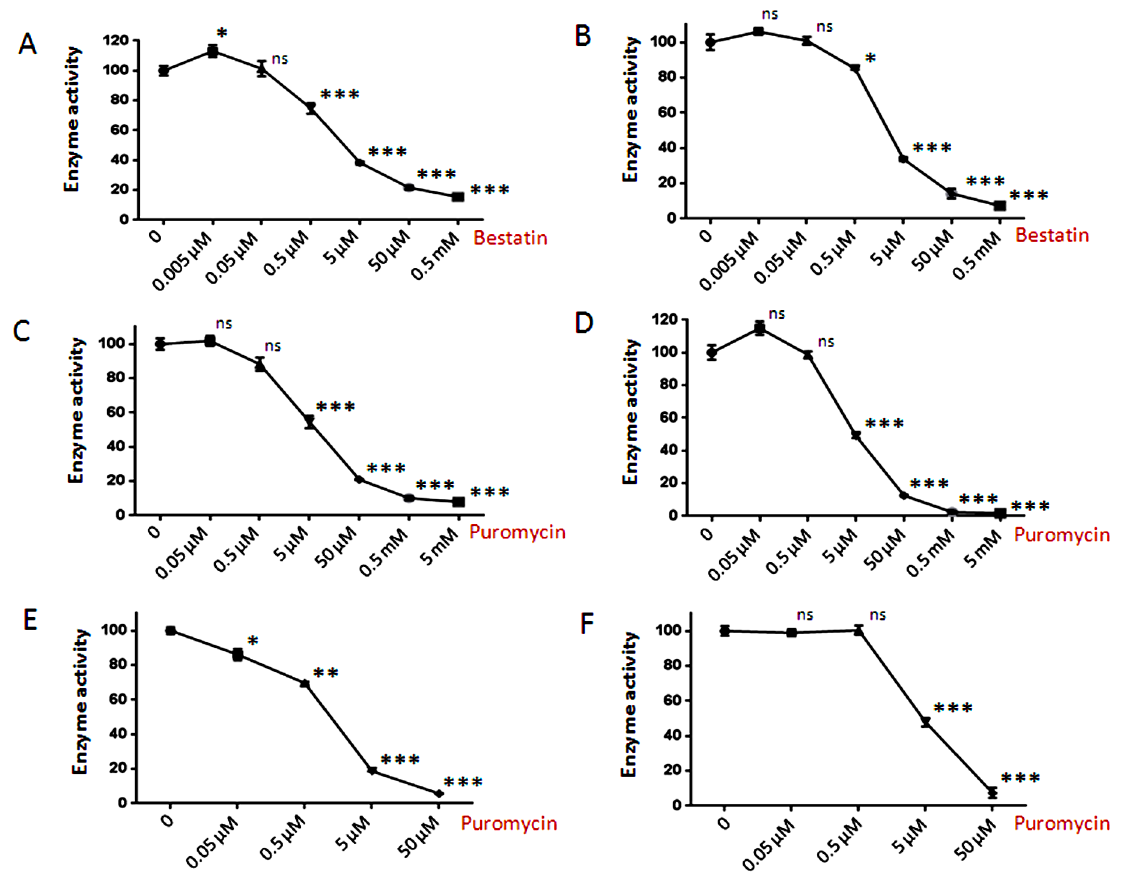
Figure 7. Effect of aminopeptidase inhibitors on Ala-AMC and Leu-AMC cleavage. HEK 293T cell extract (panels A–D) or recombinant PSAP (panels E–F) were treated with increasing concentrations of bestatin or puromycin for 30 minutes followed by the addition of substrate and incubation for 1 hour. Enzyme activity was determined by fluorescence measurement of AMC and expressed as percentage enzyme activity relative to the control without inhibitor. (A) Bestatin inhibition of HEK293T cell extract assayed with Ala-AMC. (B) Bestatin inhibition of HEK293T cell extract assayed with Leu-AMC. (C) Puromycin inhibition of HEK293T cell extract assayed with Ala-AMC. (D) Puromycin inhibition of HEK293T cell extract assayed with Leu-AMC. (E) Puromycin inhibition of purified PSAP assayed with Ala-AMC. (F) Puromycin inhibition of purified PSAP assayed with Leu- AMC. Error bars show standard error of mean (n=4), points without error bars had error ranges smaller than the symbol size. Statistical analysis was performed using Student’s t-test: *, p # 0.05; **, p # 0.01; ***, p # 0.001; ns, no significant difference (p . 0.05) versus the control.